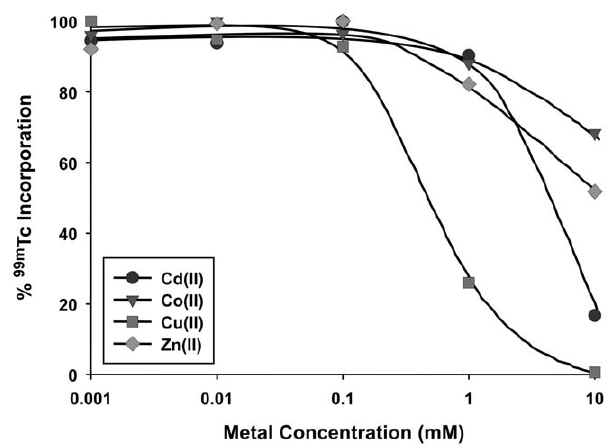
Figure 5. Concentration dependence of competition for metal binding to purified virus. Aliquots of 99m Tc-radiolabeled Ad-tGFP- pIX-MT were incubated for 15 min at 37 u C with the indicated concentrations of CdCl 2 , CoCl 2 , CuCl 2 , or ZnCl 2 . Virus bound 99m Tc was determined counting radioactivity after purification through micro spin columns.